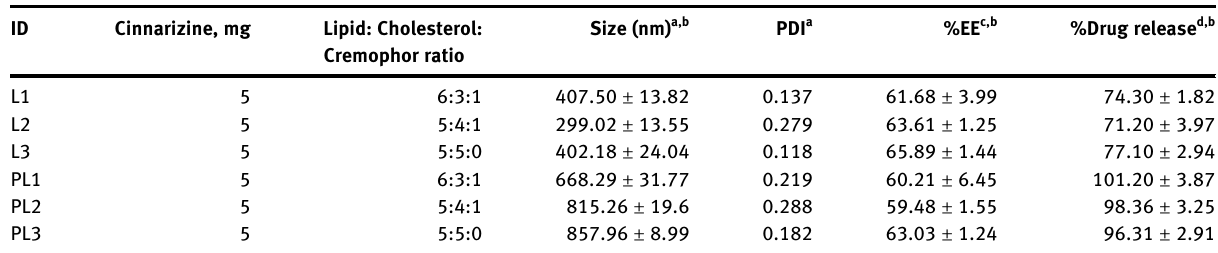
Table  : Optimisation of the liposomal and proliposomal formulations encapsulating cinnarizine (model hydrophobic small drug) and their physicochemical